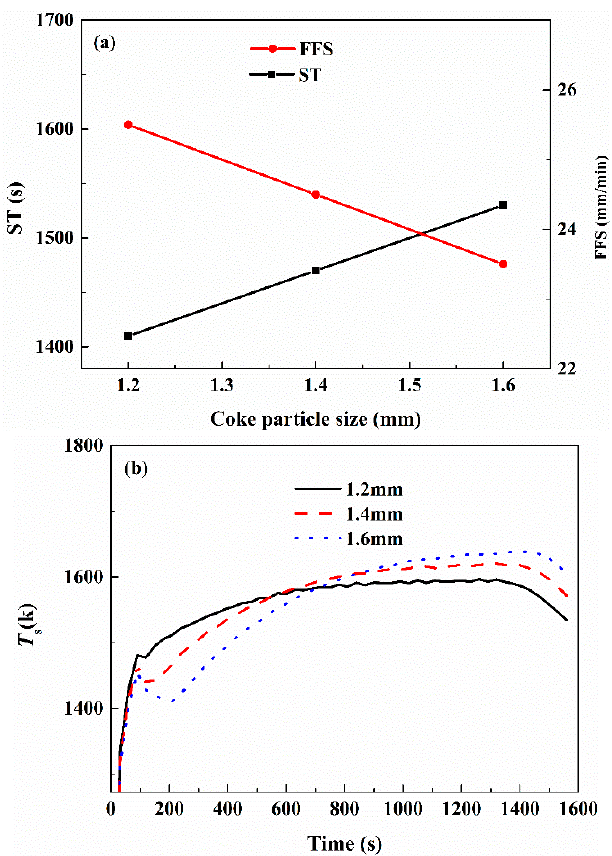
Figure 7. FFS and ST ( a ) and MaxT ( b ) with different coke particle sizes.